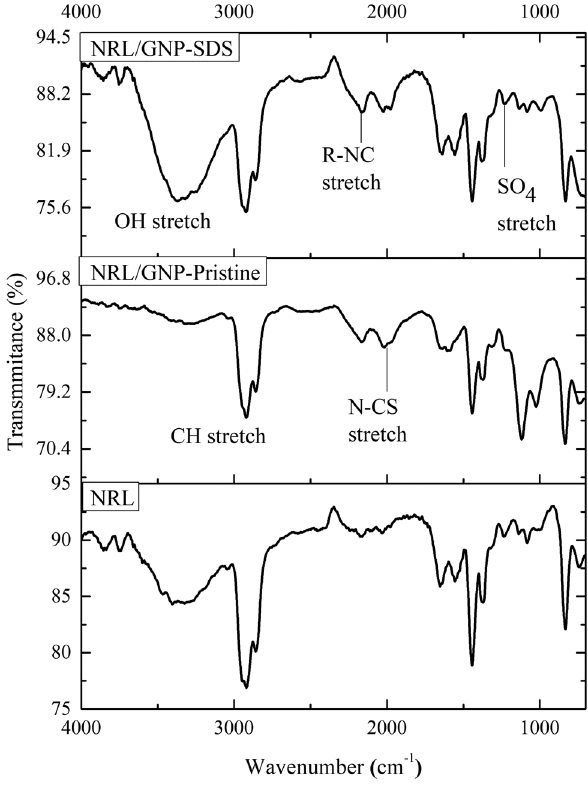
Figure 1: FTIR spectra of NRL, NRL/GNP - pristine, and NRL/GNP – SDS at 3 phr of GNP